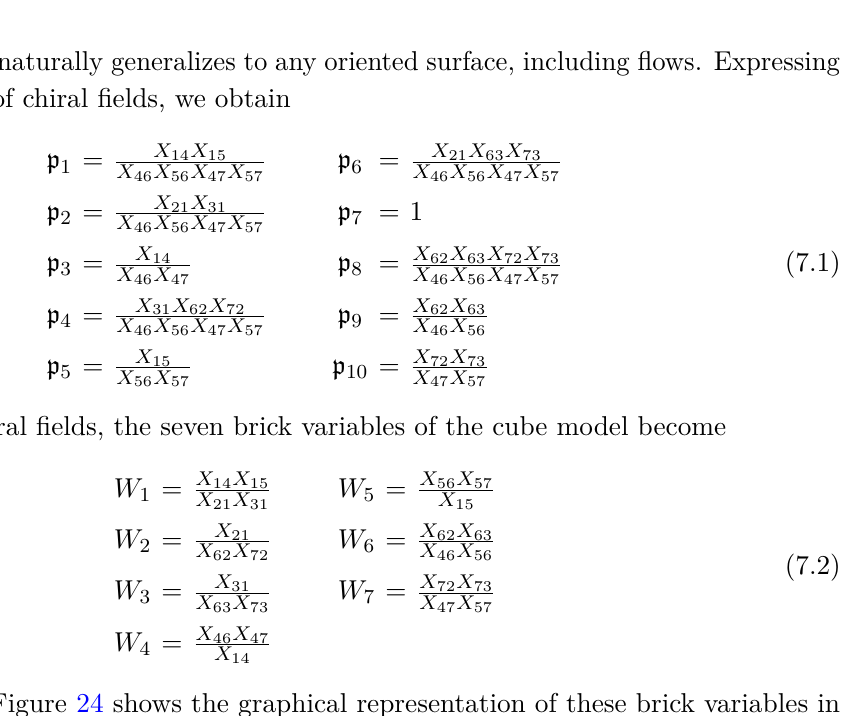
Figure 24 . Graphic representation of the seven brick variables (one internal and six external) for the cube